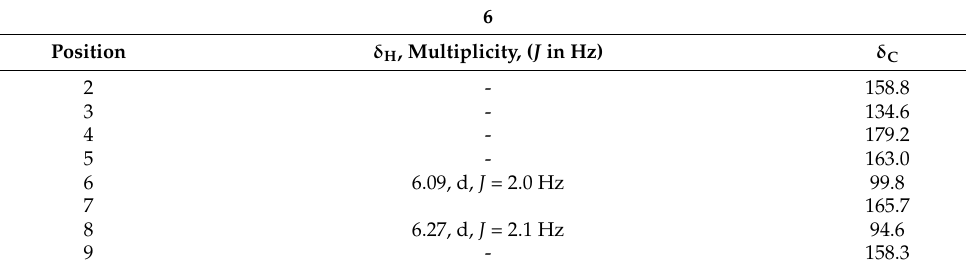
Table 1. Spectral data of compound 6